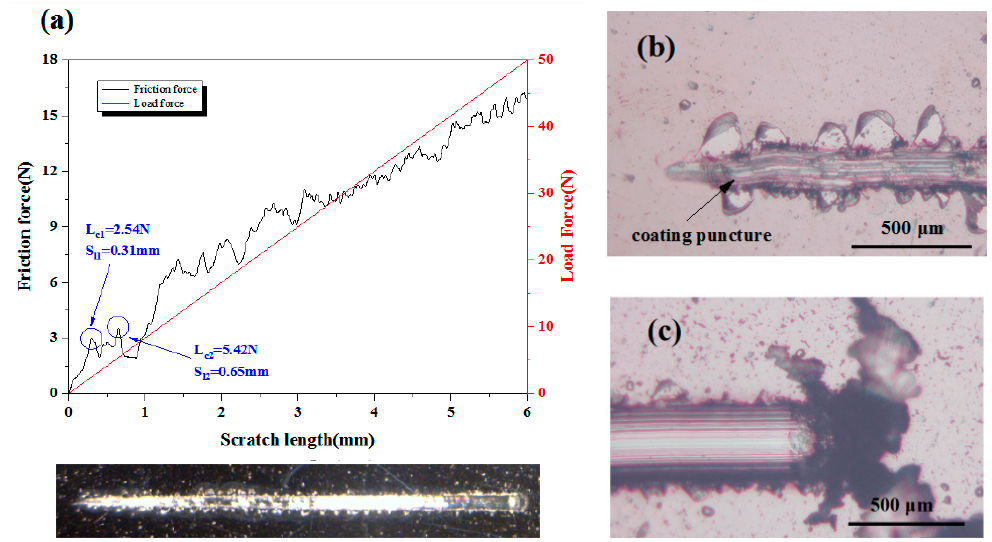
Figure 8. ( a ) Friction force and load force as a function of scratch length for Ta x O y coatings, ( b ) Scratch starting position, and ( c ) scratch end.